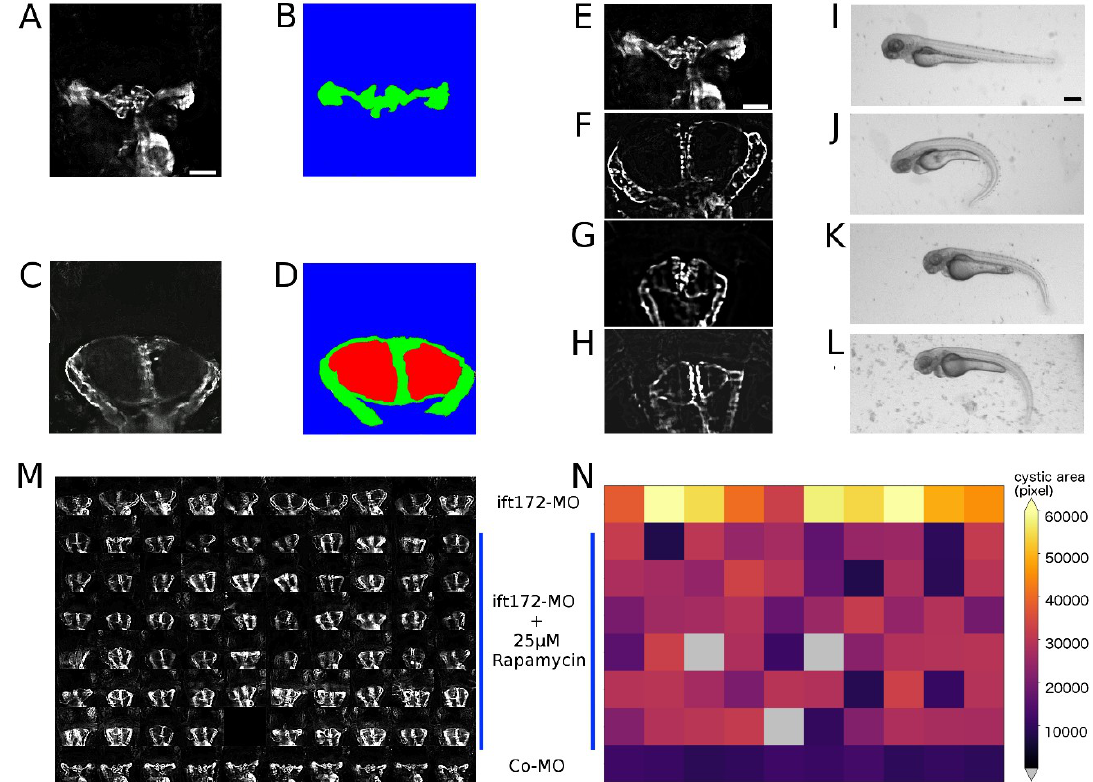
Figure 5. Automated scoring of pronephric phenotypes. ( A – D ) Quantification of pronephric tissue and cystic area in the controls ( A , B ) and cystic kidneys ( C , D ) acquired with 10x objective. Green depicts GFP-positive pronephric tissue, and red depicts cystic area. Scale bar for A–D is 50 µ m. ( E , F ) Fluorescence and stereo microscope images of dose–response experiments administering rapamycin Co-MO or ift172-MO-injected embryos at 72 hpf. ( E , I ) The control, ( F , J ) ift172-MO injected, ( G , K ) ift172-MO + 25 µ M rapamycin-exposed and ( H , L ) ift172-MO + 50 µ M rapamycin-exposed larvae are shown. Scale bar for E–H is 50 µ m and for I–L is 250 µ m. ( M ) Montage representing 72 hpf pronephros in a microtiter plate; the first row is ift172-MO injected, last row is wild type and rest of the rows are 25 µ M rapamycin-exposed larvae. ( N ) The corresponding heatmap displays rapamycin-based suppression of kidneys in reference to the cystic (first row) and wild-type (last row) controls. See also Figure S3.